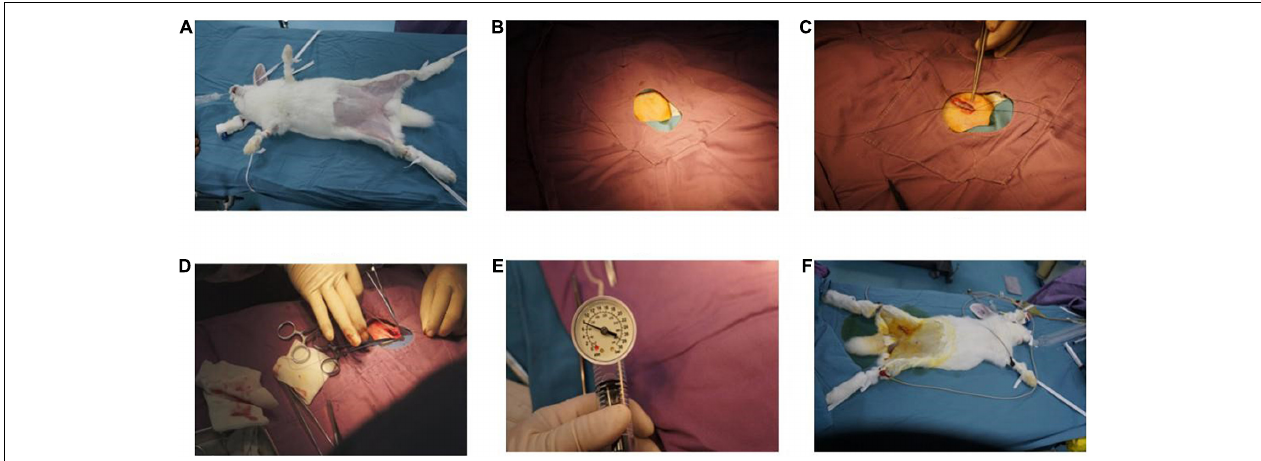
FIGURE 2 | Balloon sprained and injured experiment: (A) immobilization of animals, anesthesia, and skin preparation. (B) Disinfect, spread towel, and expose incision. (C) Free femoral artery. (D) Balloon catheter was implanted. (E) The balloon was filled with gas and was pulled repeatedly in abdominal aorta for three to five times. (F) The incision was sutured, and the operation was